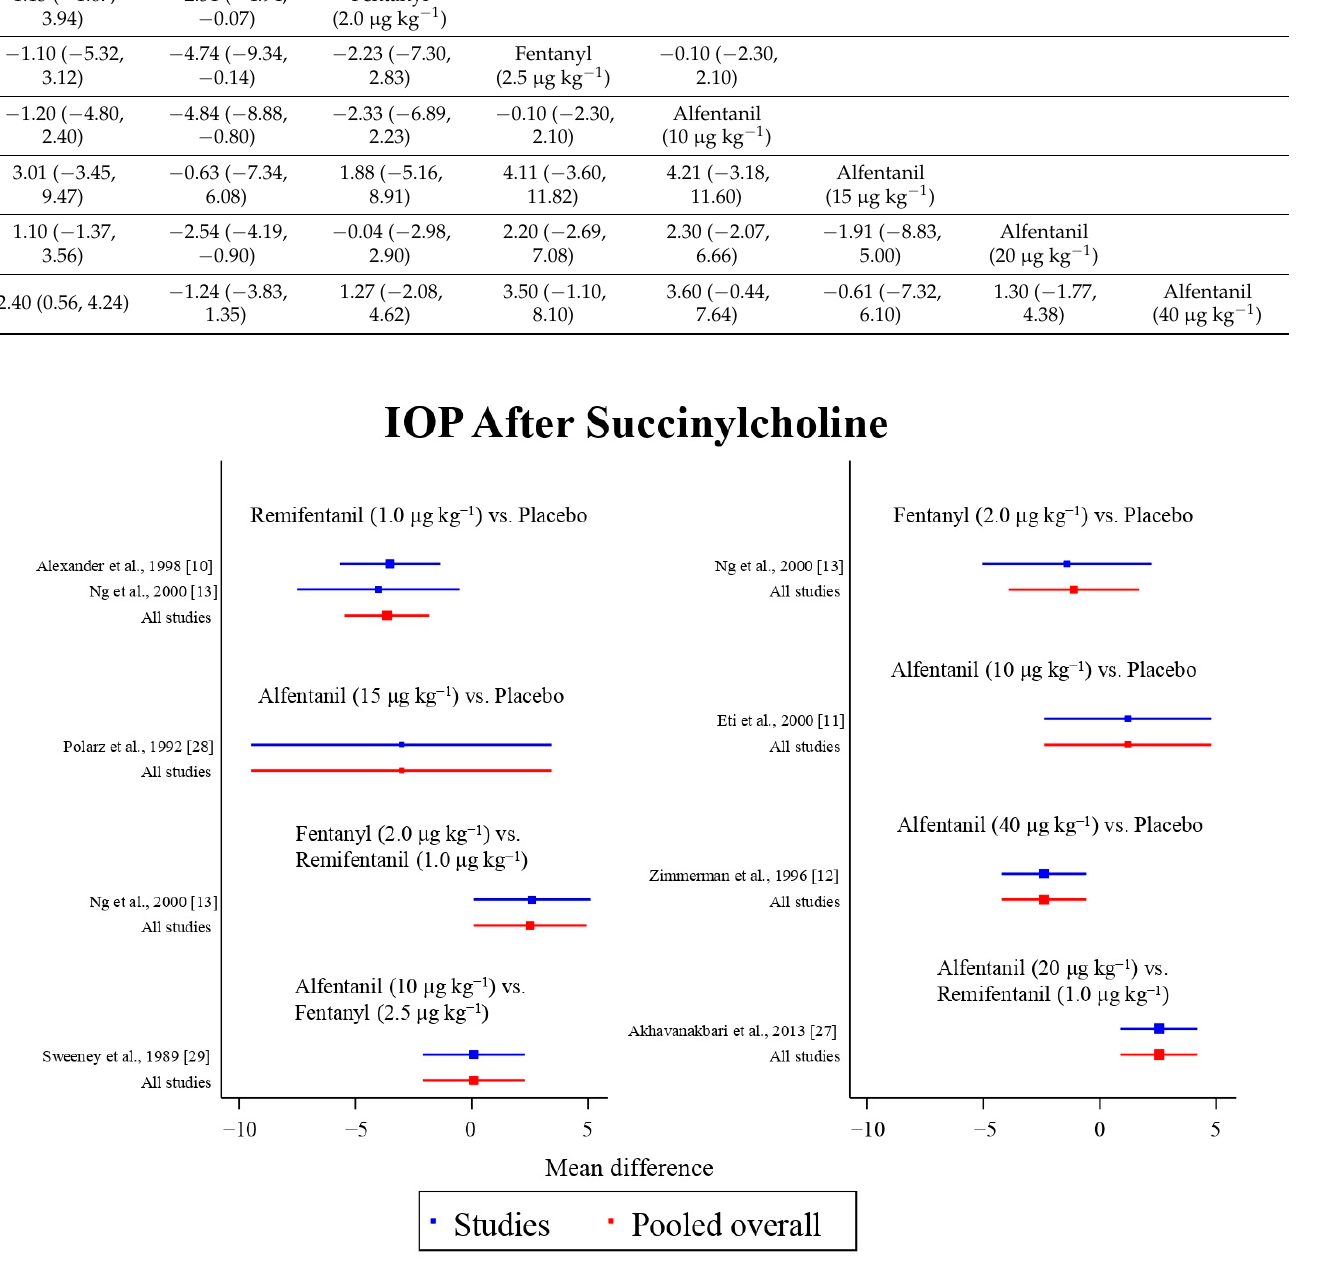
Figure 8. The network meta-analysis forest plot. The blue dots and lines indicate the studies contributing the direct evidence. The red dots and lines indicate the pooled overall network estimates of the treatment effects. See refs [10–13,27–29].